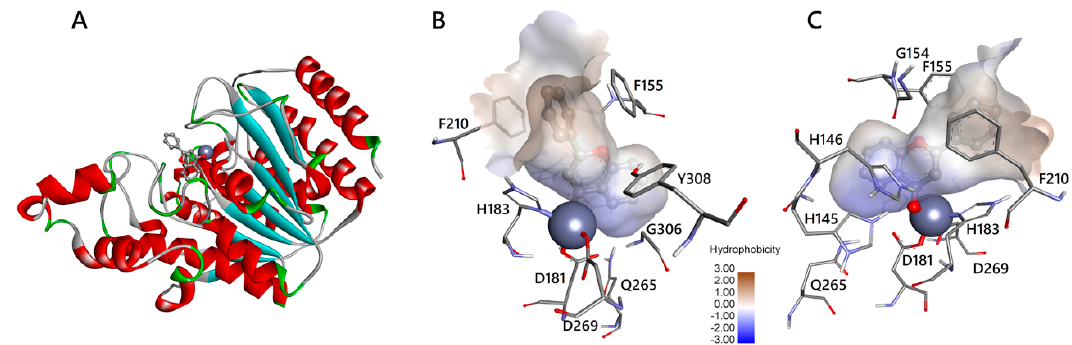
Figure 4. Interaction of flavone with HDAC2. ( A ) HDAC2 with flavone in the interaction with zinc ion resulting from docking simulation. Colours and representations are as in Figure 3. ( B ) flavone in the catalytic channel of HDAC2. Amino acids are labelled as in Figure 3. Zinc ion, represented as a sphere, is coordinated by the carbonyl oxygen of flavone ring C and D181, H183, D269. Atoms and bonds are coloured and represented as in Figure 3. ( C ) the opposite view of panel B shows the position of amino acids not visible in the other panel. Images are generated by DiscoveryStudio4.5.